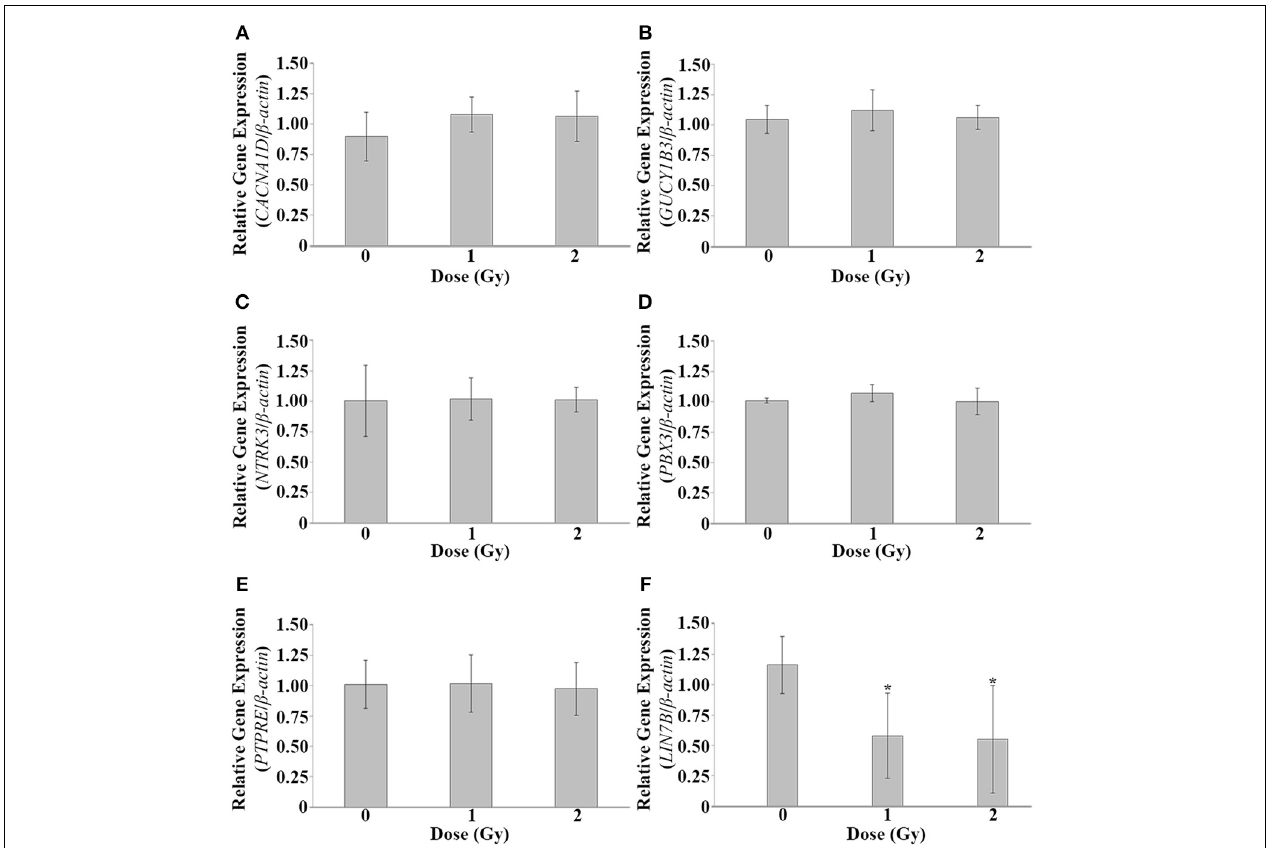
FIGURE 3 | Gene expression analysis at 1 and 2 Gy. Gene expression alterations in CACNA1D , GUCY1B3 , LIN7B , NTRK3 , PBX3 , and PTPRE were assessed at 120hpf following dosing at 1 and 2 Gy at 26hpf. No significant expression alterations were observed at these